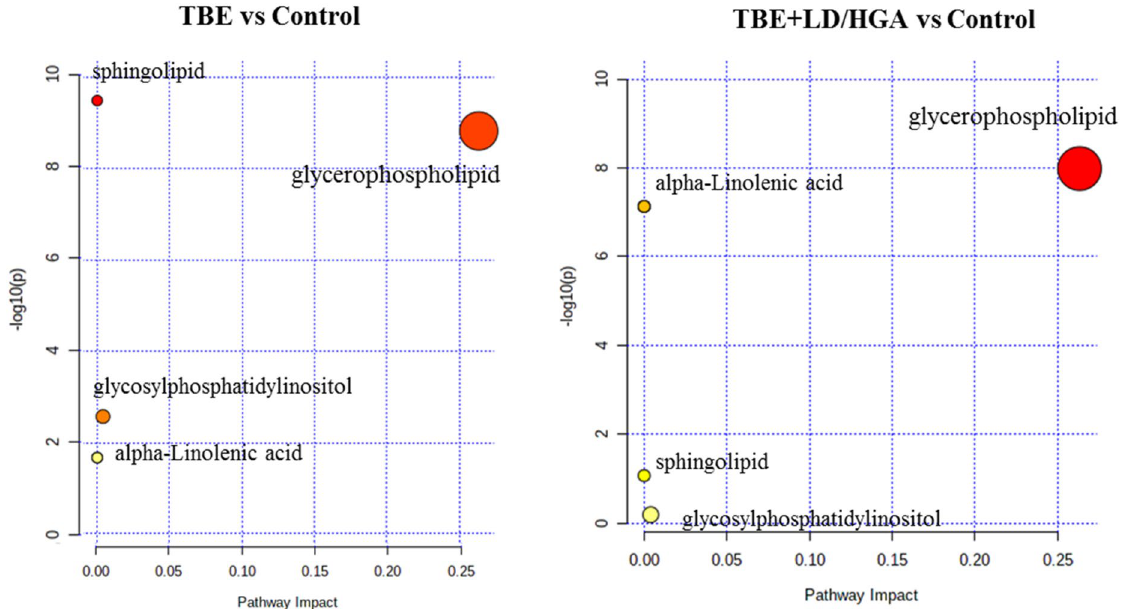
Figure 6. Graphical representation of the pathway analysis of TBE patients vs healthy subjects; left panel pathway analysis of differentiating lipids in the TBE vs control group, right panel pathway analysis of differentiating lipids in the TBE + LD/HGA vs control group. The gradual color of each circle reperesents the p -value (the lower p-value the color changes from yellow to red), while the size of each circle represents pathway impact (a combination of the centrality and number of PL species enriched in the